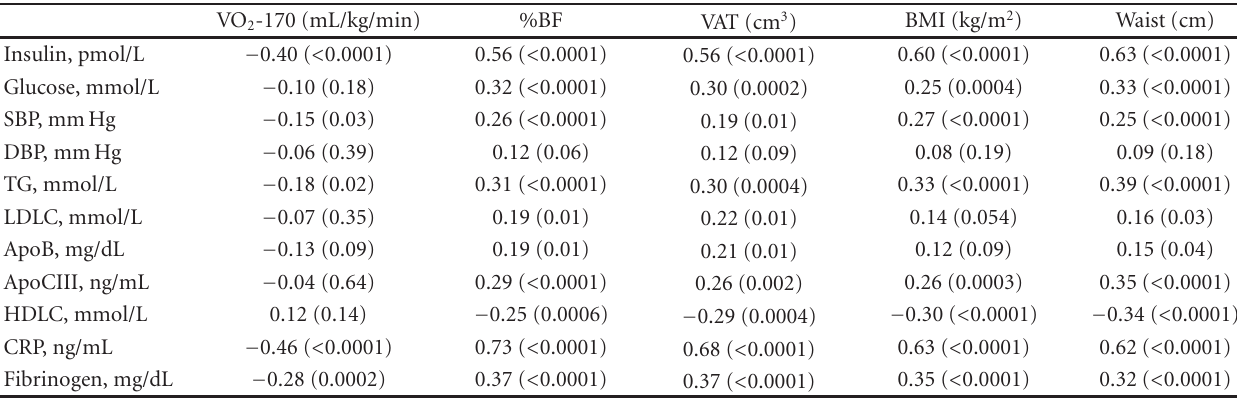
Table 2: Baseline Spearman correlations ( P values) between aerobic fitness and fatness indices with cardiometabolic biomarkers. VO 2 -170